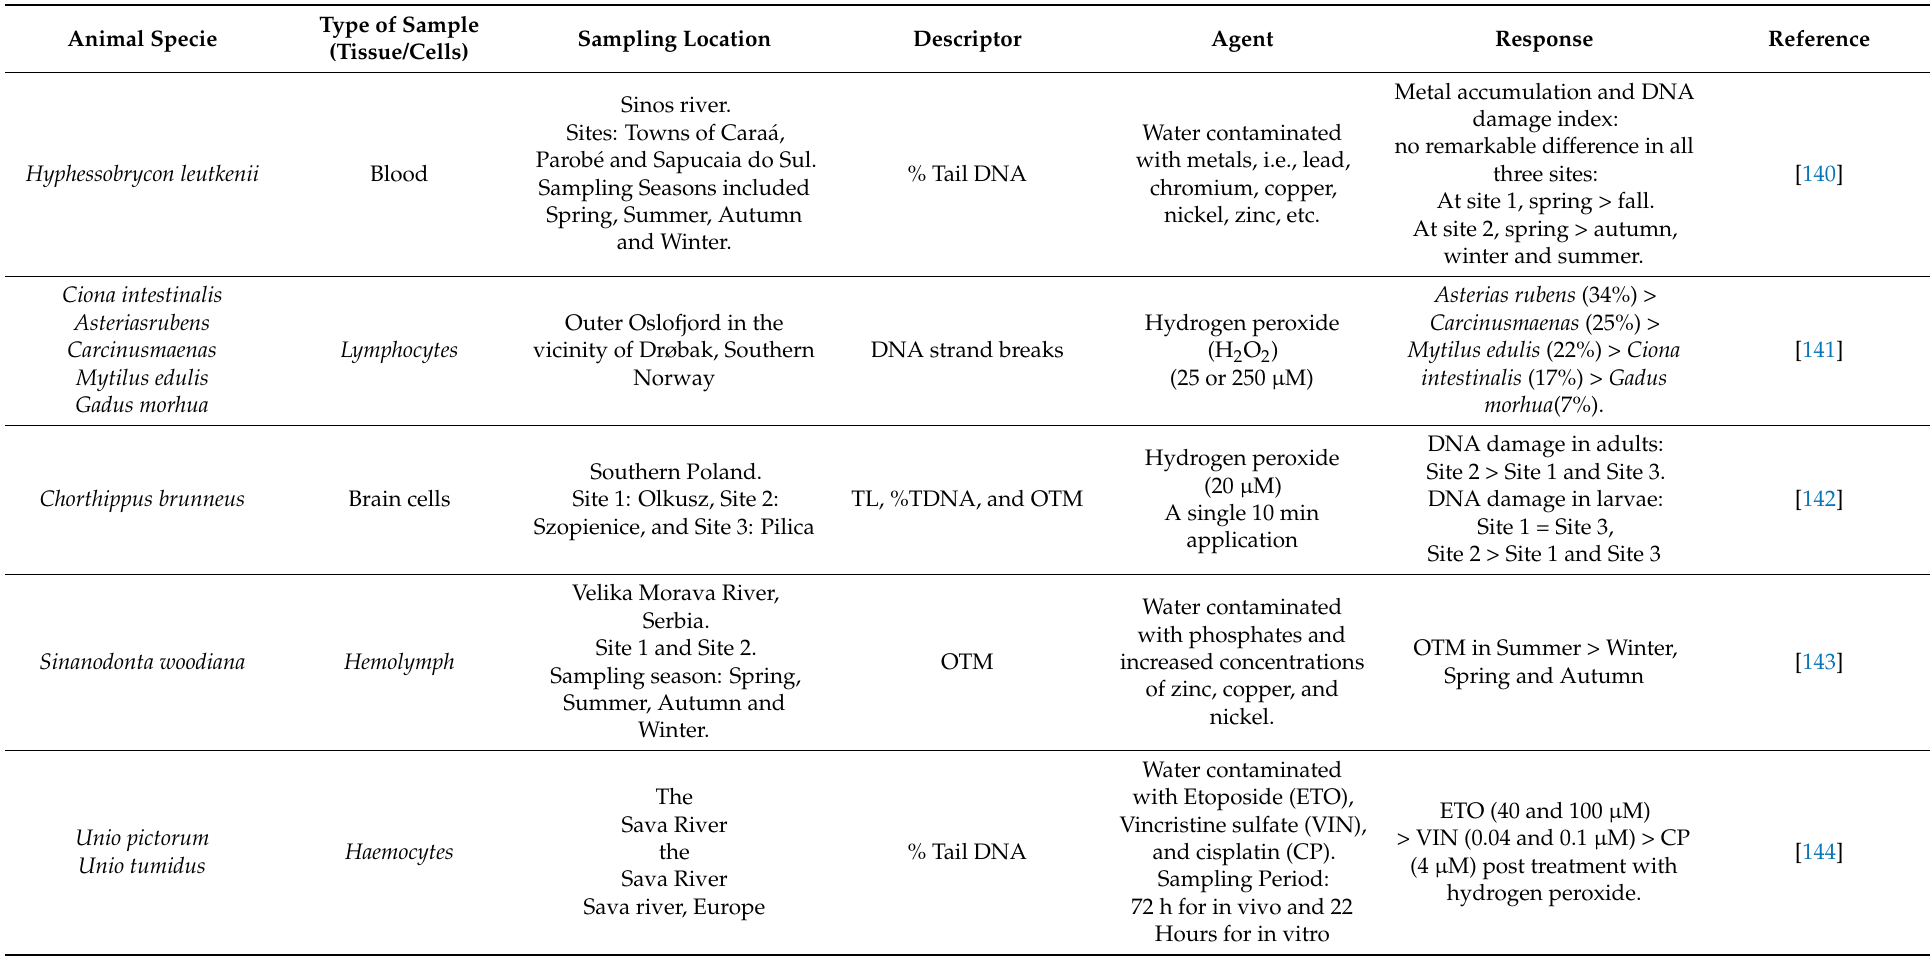
Table 4. Assessment of DNA damage by comet assay in different cells of aquatic animals obtained from polluted